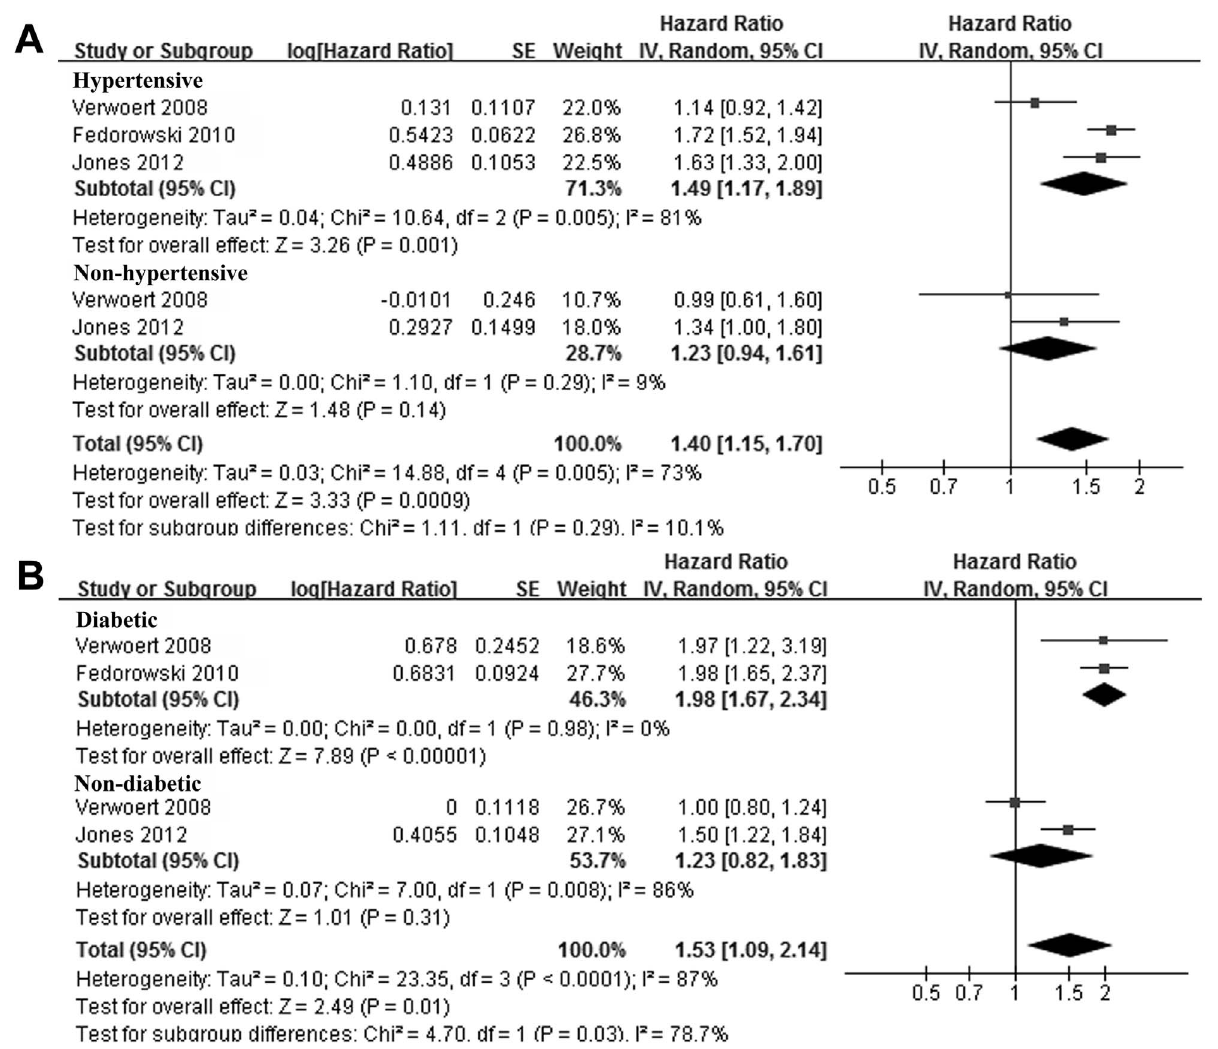
Figure 4. Adjusted hazard ratio of congestive heart failure in subjects with orthostatic hypotension at baseline compared those without orthostatic hypotension stratified by the comorbidities of hypertension (A) and diabetes mellitus (B) of the subjects. CI, denotes confidence interval; the size of each square is proportional to the study’s weight (inverse of variance – IV).